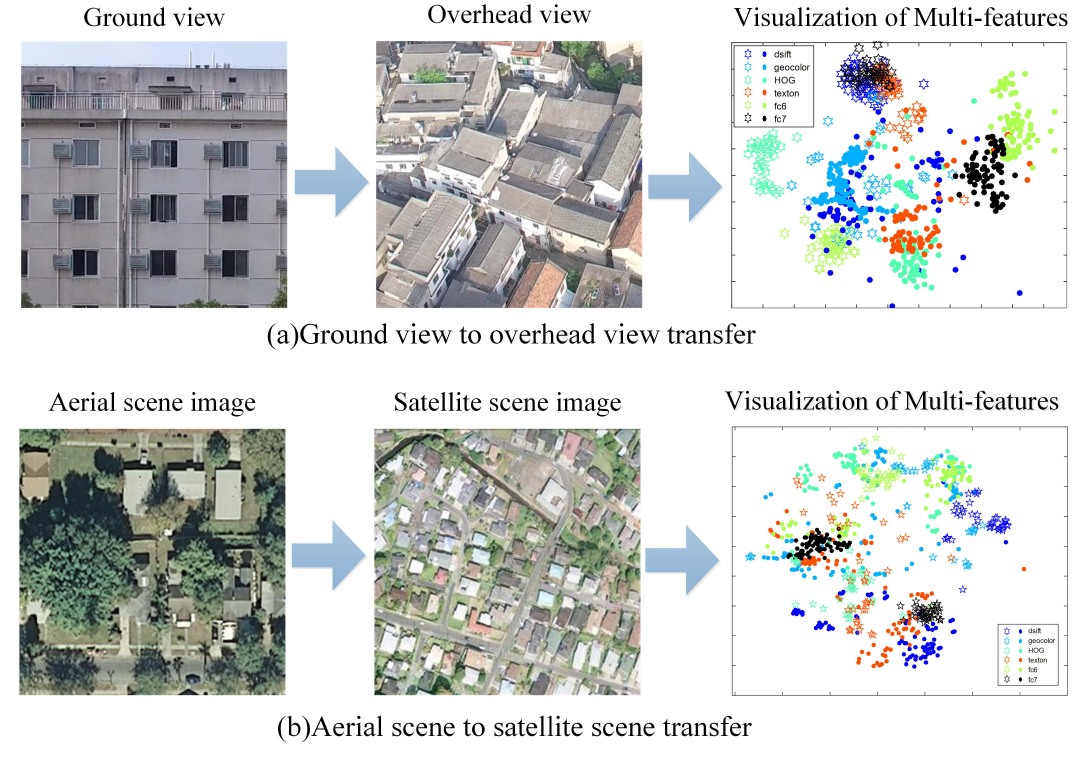
Figure 1. Ground-to-overhead view and aerial-to-satellite scene transfer